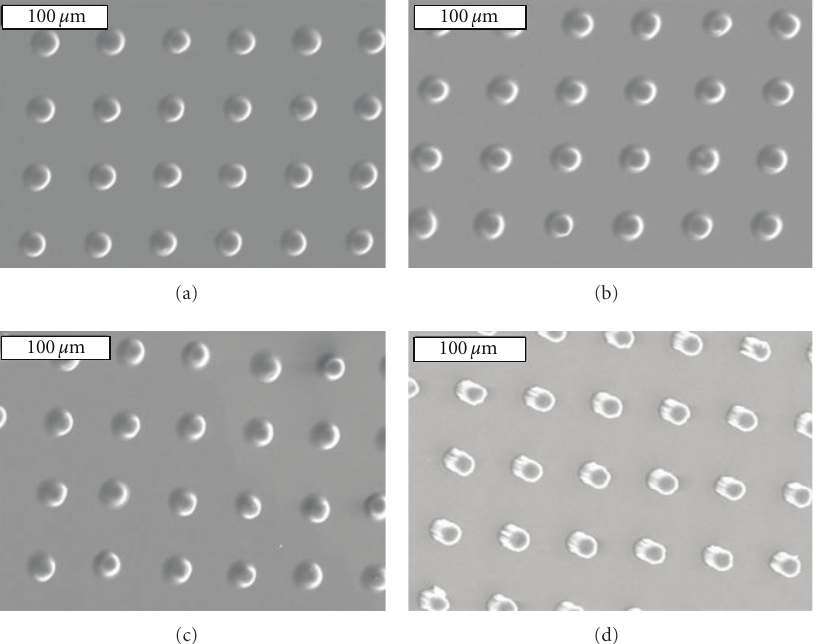
Figure 18: D20-B SEM image of each scale (a) the first scale (34 µ m), (b) the second scale (23 µ m), (c) the third scale (13 µ m), and (d) the forth scale (6 µ